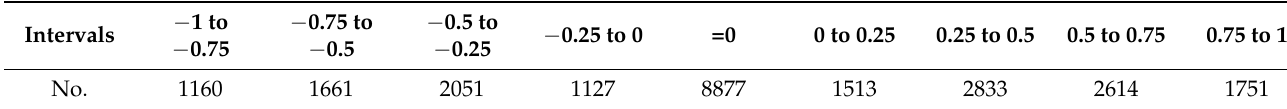
Table 5. Number of positive, negative, and neutral tweets in 0.25 intervals.